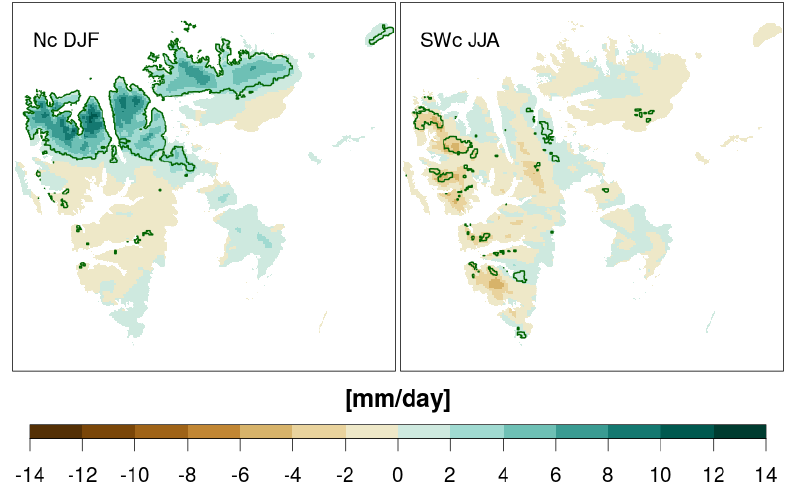
Figure 11. Mean precipitation changes (from 1971–2000 to 2071–2100) for the weather type Nc in winter ( left ) and SWc in summer ( right ). Statistically significant changes are